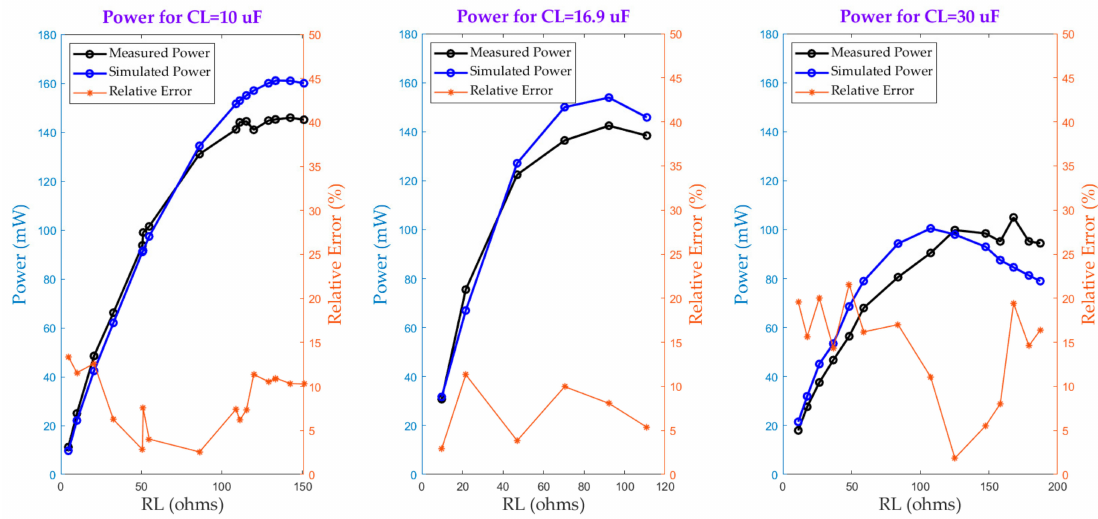
Figure 9. Verification of Model 2